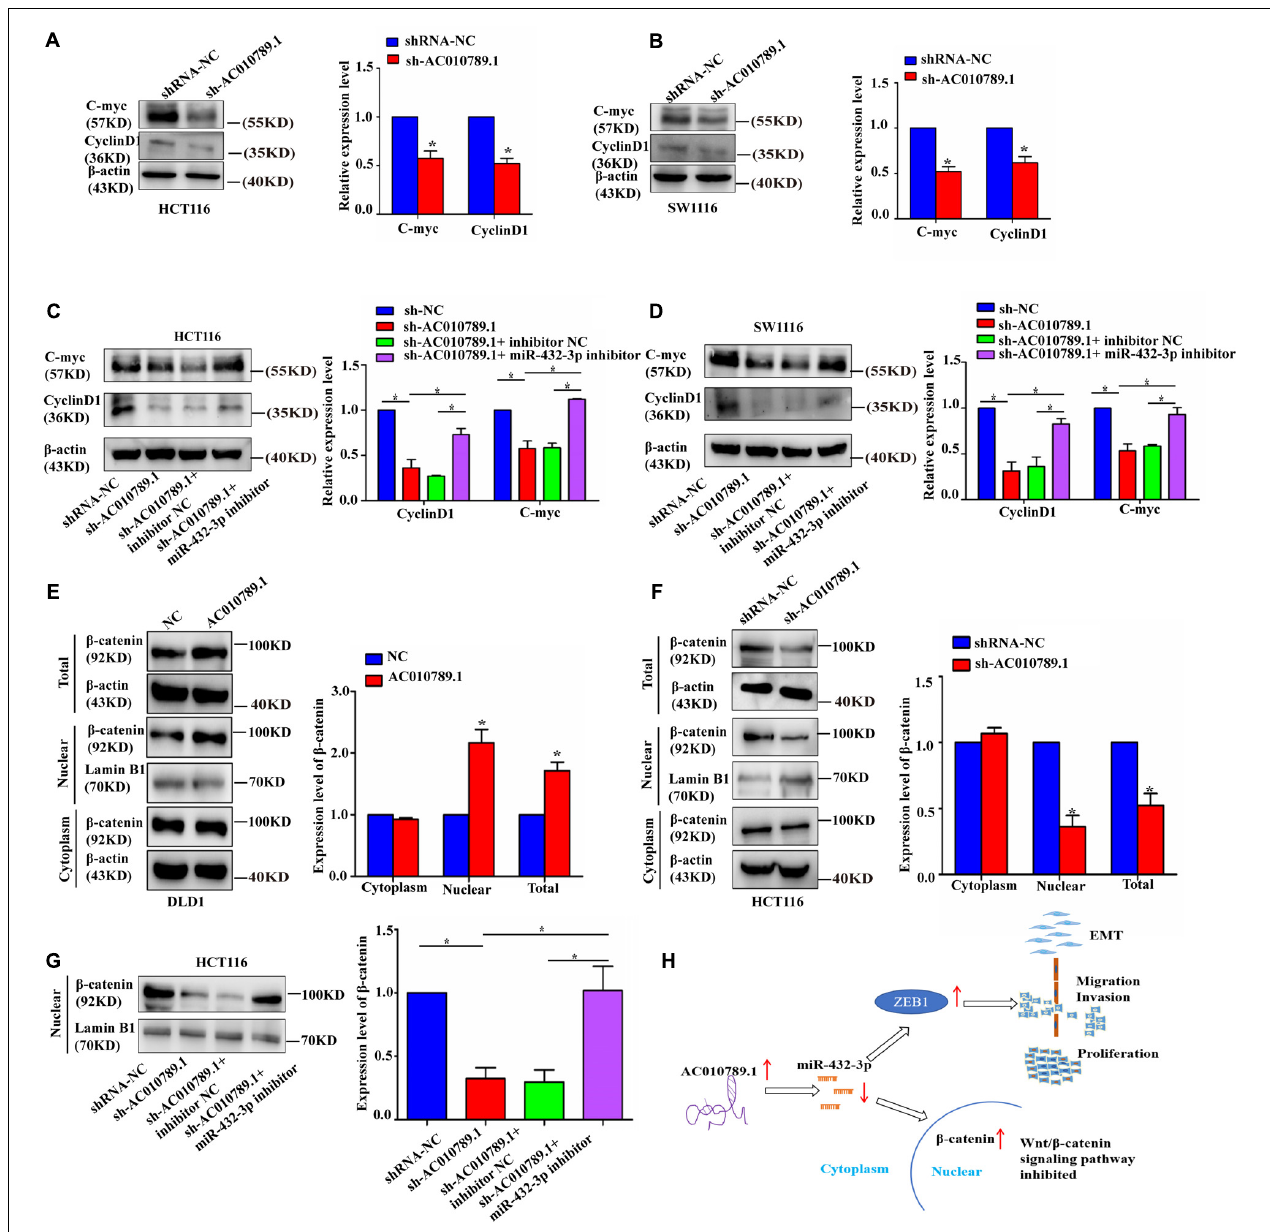
FIGURE 7 | AC010789.1 expression level correlates with Wnt/ β -catenin pathway activation in CRC cells. (A, B) The protein expression levels of Wnt-responsive genes in HCT116 and SW1116 cells with AC010789.1 stable knockdown. (C, D) Western blot analysis of C-myc and cyclin D1 in HCT116 and SW1116 cells transfected with shRNA-NC, sh-AC010789.1, sh-AC010789.1 + inhibitor NC, sh-AC010789.1 + miR-432-3p inhibitor. (E) Western blot analysis showed the β -catenin protein levels of total, nuclear, and cytoplasmic in DLD1 cells with AC010789.1 overexpression. (F) Western blot analysis showed the β -catenin protein levels of total, nuclear, and cytoplasmic in HCT116 cells with AC010789.1 knockdown. (G) Western blot analysis showed the β -catenin protein level of nucleus in HCT116 cells transfected with shRNA-NC, sh-AC010789.1, sh-AC010789.1 + inhibitor NC, sh-AC010789.1 + miR-432-3p inhibitor. (H) Schematic diagram of the regulatory mechanism of AC010789.1 on CRC proliferation, metastasis and EMT. AC010789.1 is upregulated in CRC, and results in downregulation of miR-432-3p. The decreased expression of miR-432-3p leads to an upregulation of ZEB1 whose function is to promote EMT, migration and proliferation. The decreased expression of miR-432-3p also results in increased levels of nuclear β -catenin, resulting in increased Wnt/ β -catenin signaling. Data are representative of three independent experiments and are presented as mean ± SEM. P -values were determined by two-tailed student’s t -test or one-way ANOVA (* P <